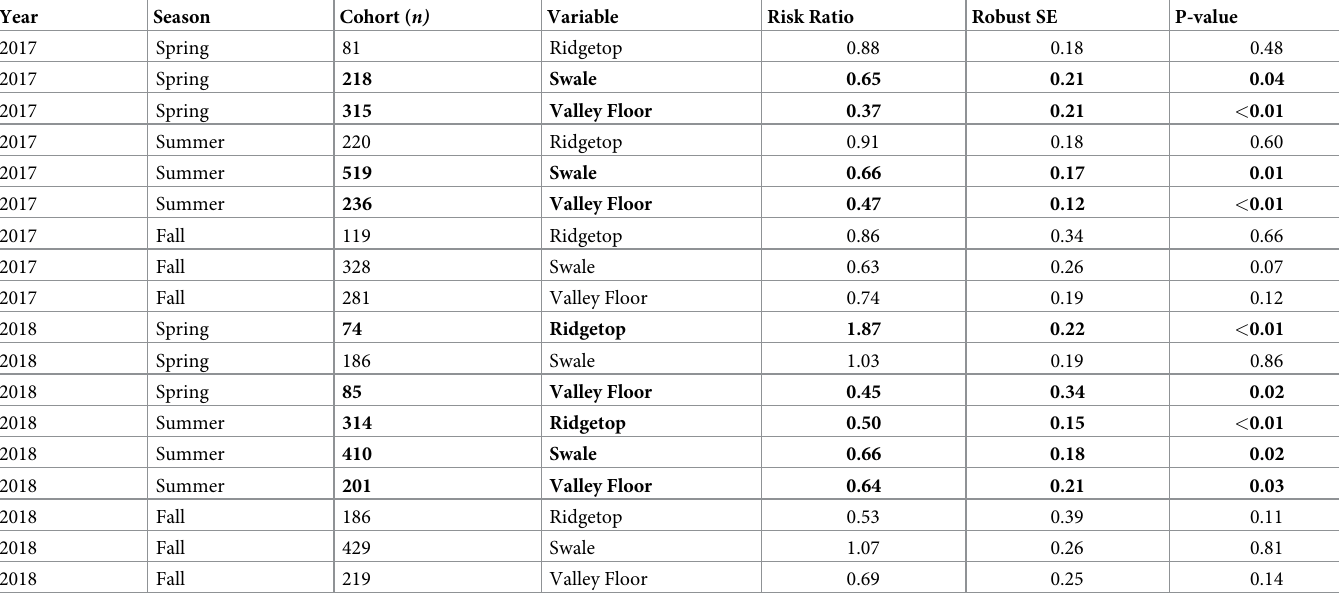
Table 1. Topographic proportional hazards table for different years and seasons.